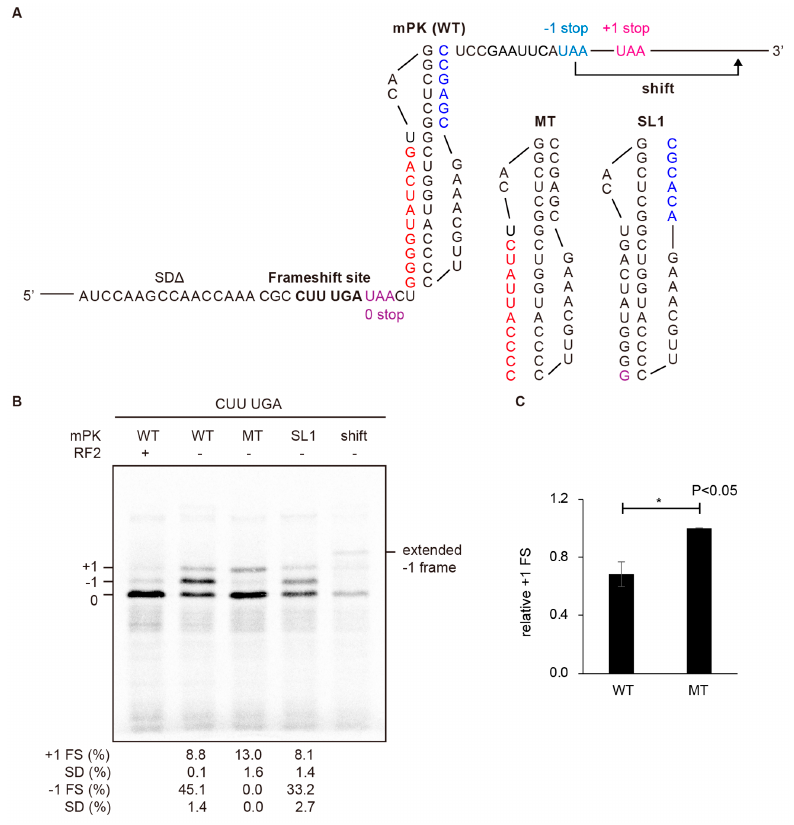
Figure 3. Reduced +1 frameshifting by a downstream pseudoknot coexists with an unusual frameshifting event in the absence of RF2. (A) Sequences of the constructs designed to evaluate